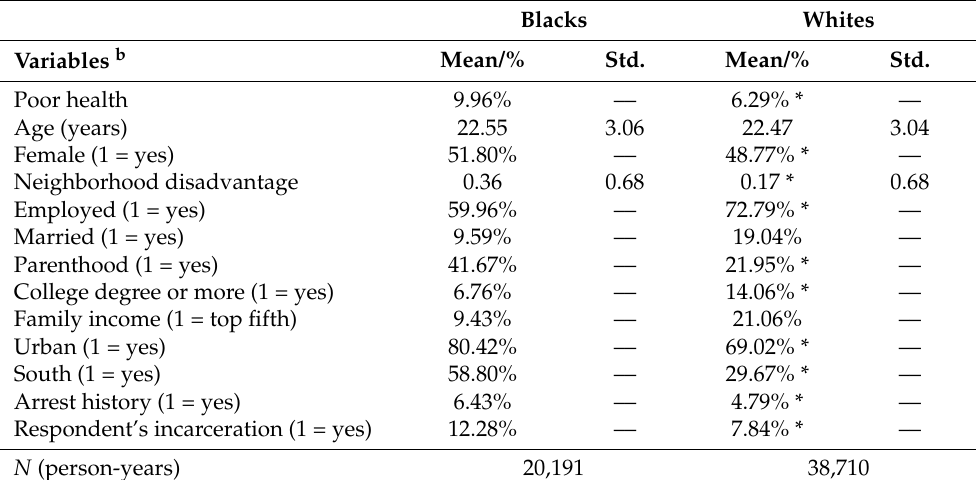
Table 1. Mean/proportions for all study variables by race a . National Longitudinal Survey of Youth 1997 (NLSY97), 1997–2013 b